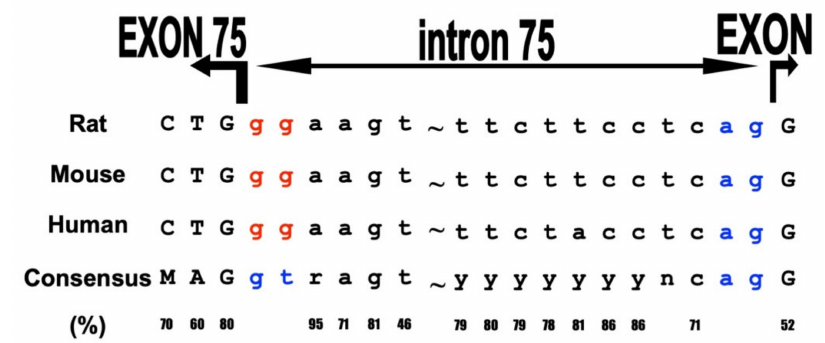
Figure 6. Usage of “gg” in splice donor sites of rat, mouse, and human RyR2 intron 75 (adapted from [64,68]). RNA splicing in eukaryote follows the “GT-AG” rule by both cis-elements and regulatory trans-acting factors. Donor site dinucleotides of RyR2 intron 75 in rat, mouse, and human are “gg” but not consensus “gt.” In consensus, “M”, “r”, “y”, and “n” represent A or C, a or c, c or t, and a, c, g, or t,